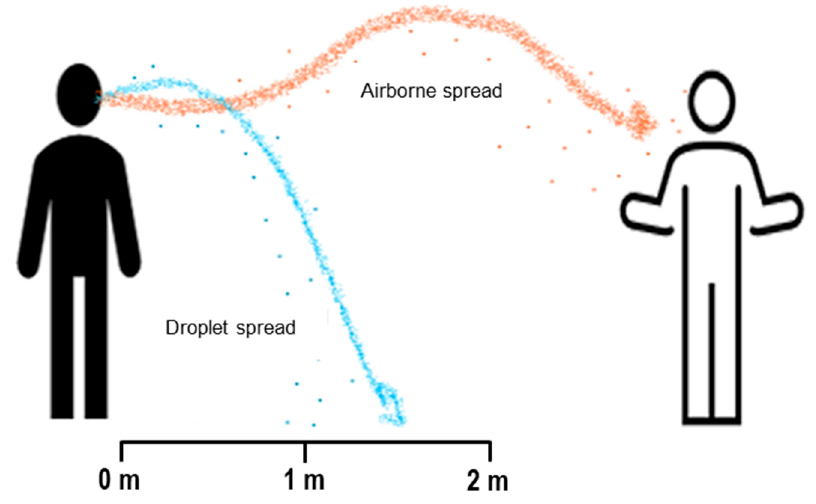
Figure 4. Airborne and droplet spread of respiratory droplets.